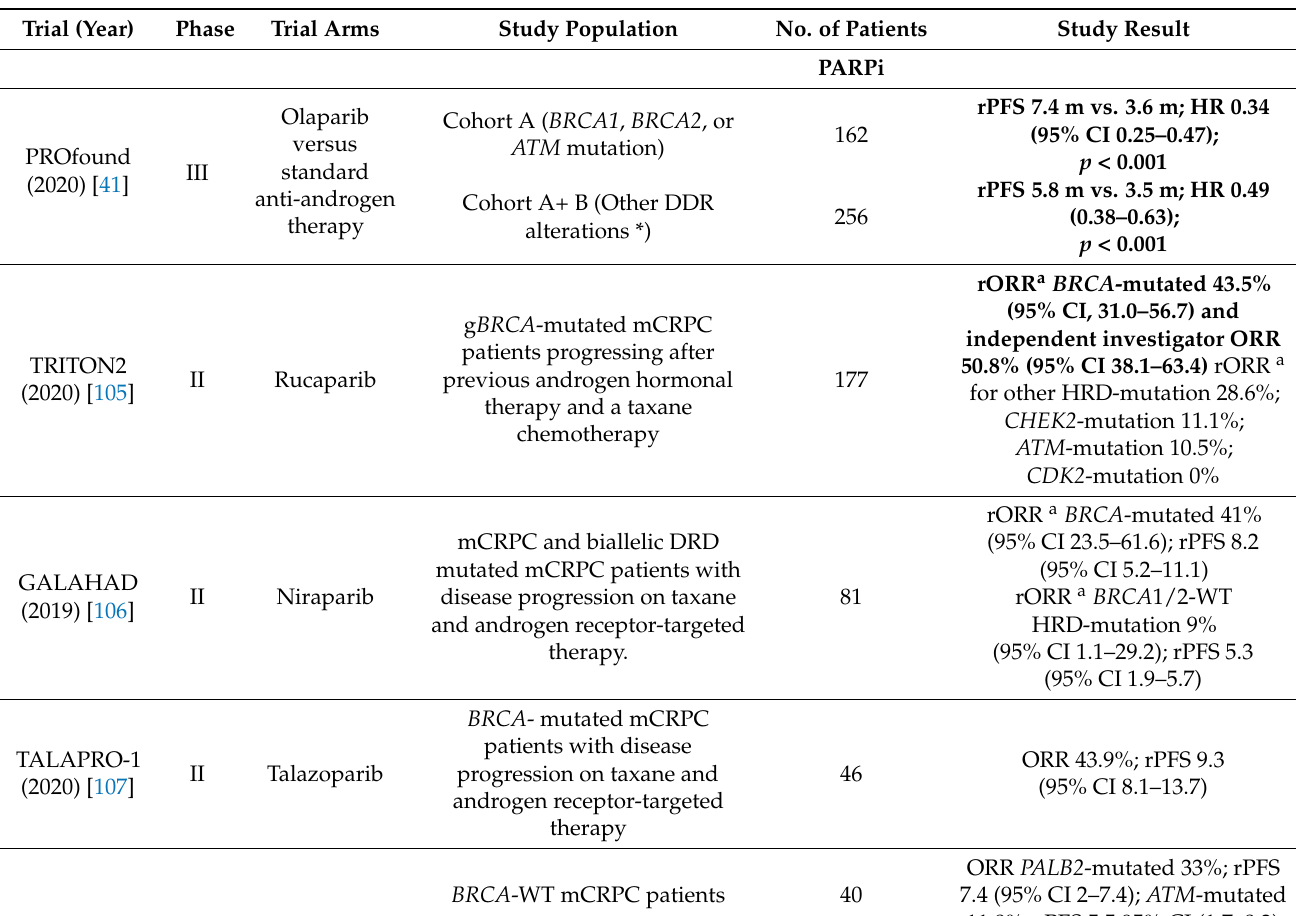
Table 4. Summary of clinical trials involving PARPi and BRCA -positive mCRPC